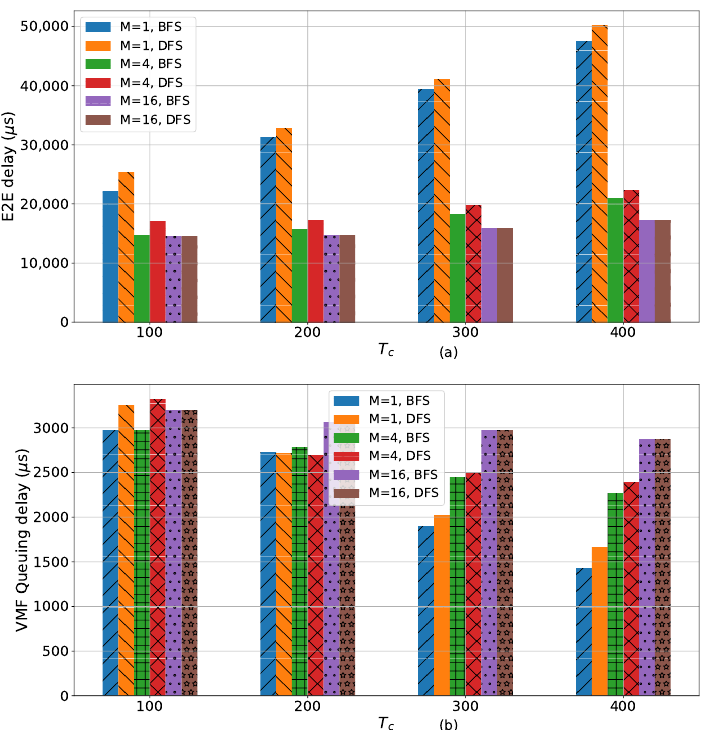
Figure 6. ( a ) The average E2E delay and ( b ) the average queuing delay versus cycle time ( T c